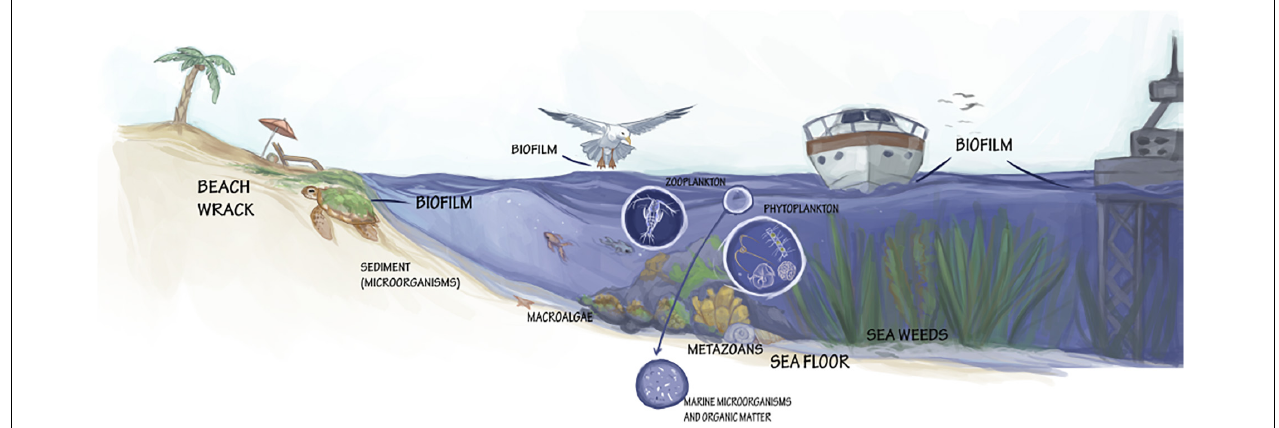
FIGURE 2 | Various formations and taxa with valorization potential for marine